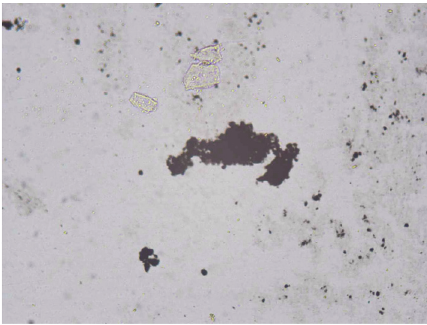
Figure 2: Optical microscope image of CNT dispersion after the treatment with 400 J/mL of US energy, magnified 20